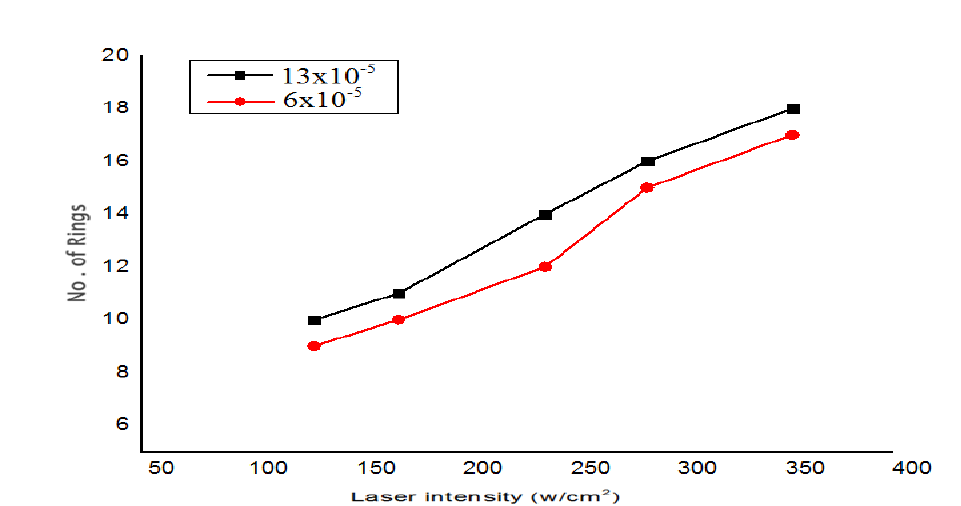
Fig.9: The diffraction rings from DI water (F-SWCNTs) suspension different laser densities at volume fraction13 × 10 - 5 and 6 × 10 - 5 .